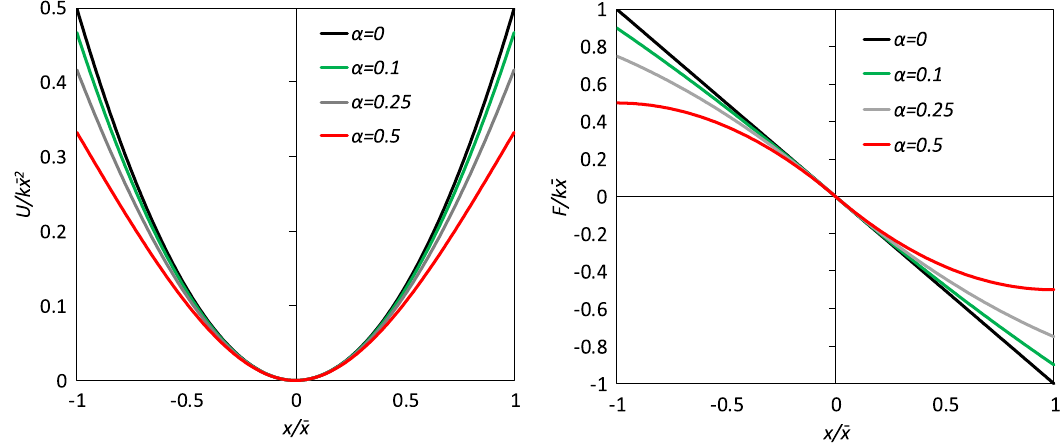
ð x Þ (right) as a function of the relative vortex displacement x= ¯ x for various values of the parameter α FIG. 1. Plots of U ð x Þ (left) and f p